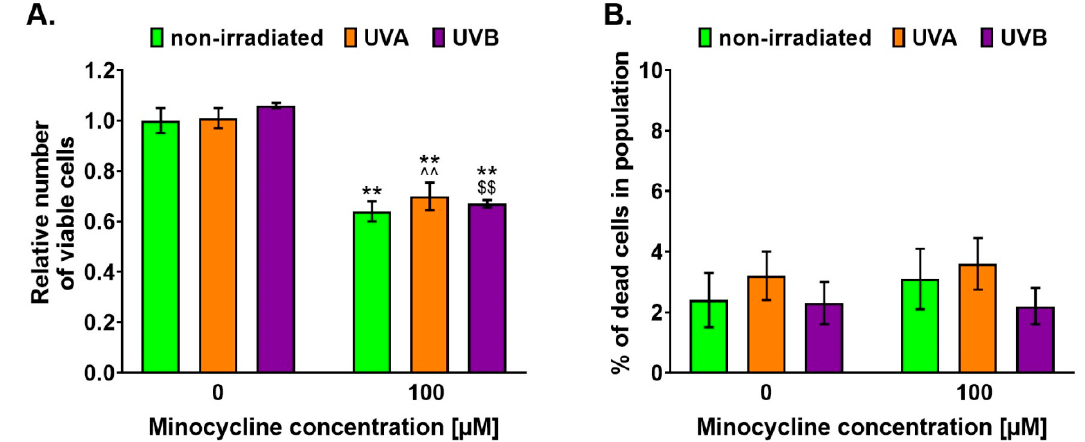
Figure 2. Minocycline inhibits the growth of human melanocytes but does not increase the percentage of dead cells. UVA and UVB radiation do not influence the effects. The results are presented as ( A ) the relative number of viable cells ( B ) and the percentage of dead cells in the tested population. ** p < 0.005 vs. non-irradiated cells; ^^ p < 0.005 vs. UVA-irradiated cells; $$ p < 0.005 vs. UVB-irradiated cells.